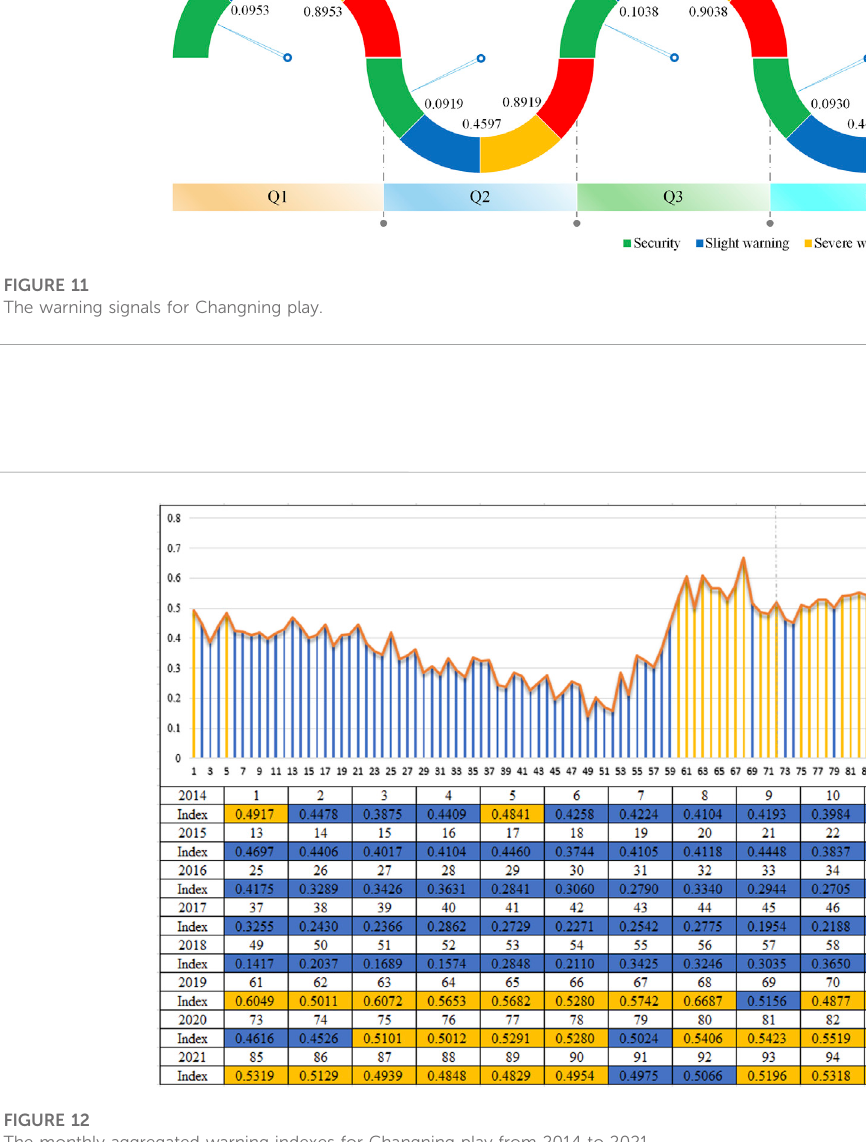
Figure 10 and the warning signals for Changning play shown in Figure 11. The blue parts of the table in the latter half of Figure 12 and the vertical blue lines in the upper half of Figure 12 denote a slight warning in the months. The yellow parts and the vertical yellow